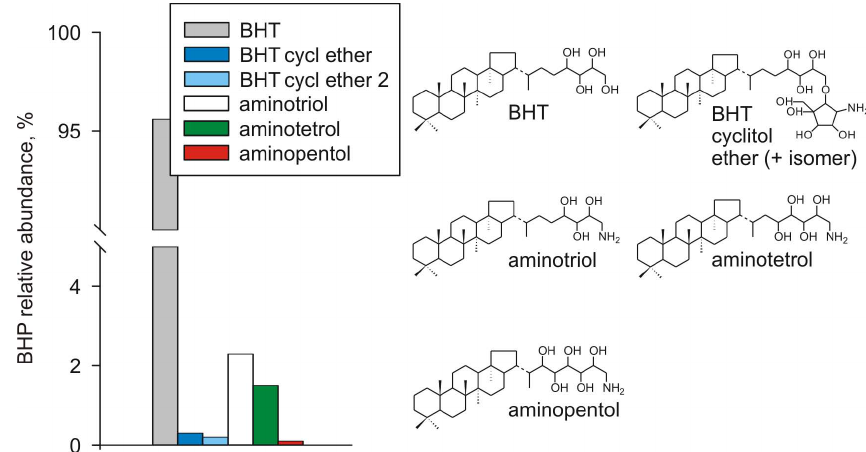
Fig. 4. The relative abundances of specific bacteriohopanepolyols (BHPs) sampled in 100m water depth, together with the chemical structure of each compound. BHT = bacteriohopanetetrol; cycl =